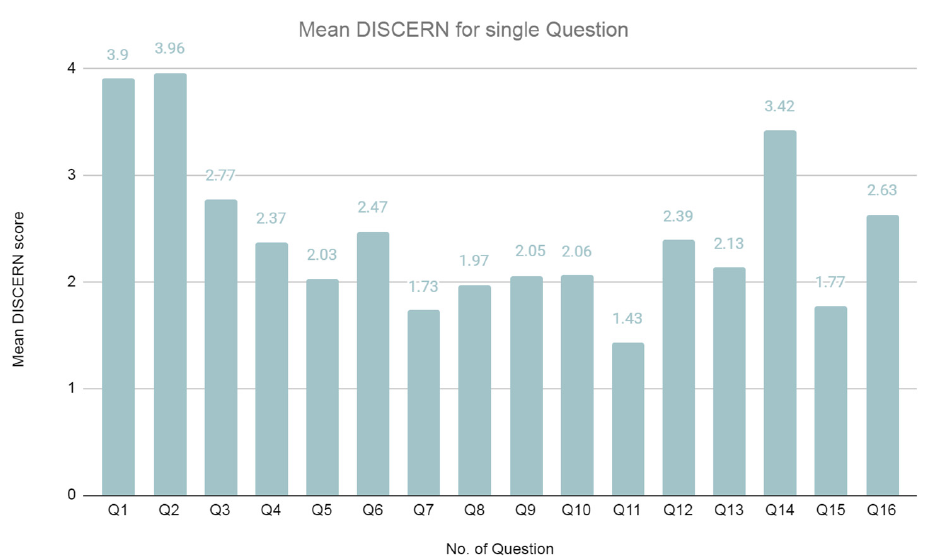
Figure 1. Percentage observed in DISCERN categories.